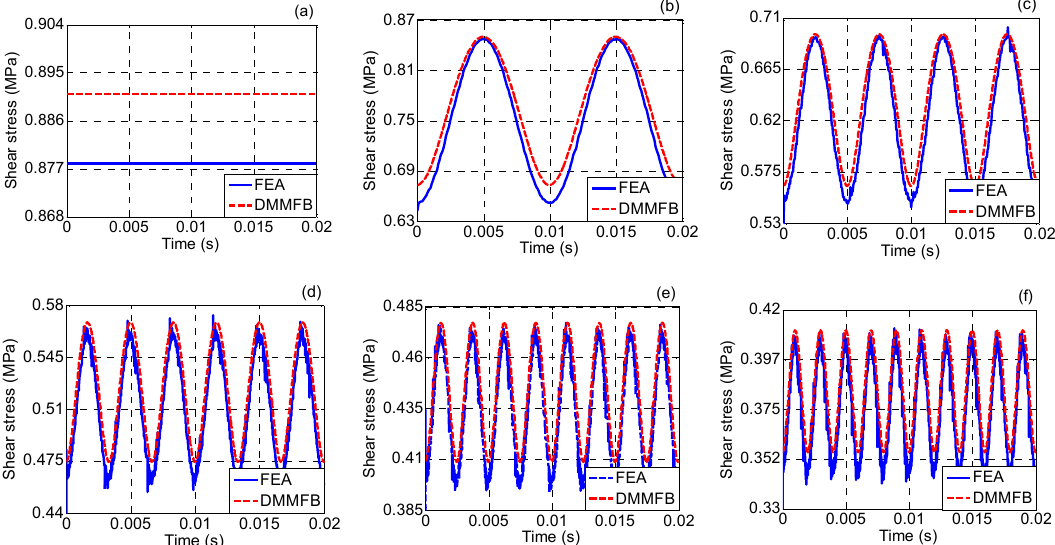
Figure 8. The shear stress at the internal wall of the extrusion liquefier without and with 0.25 g vibration applied at different frequencies. ( a ) No vibration applied, ( b ) 100 Hz, ( c ) 200 Hz, ( d ) 300 Hz, ( e ) 400 Hz, ( f ) 500 Hz.